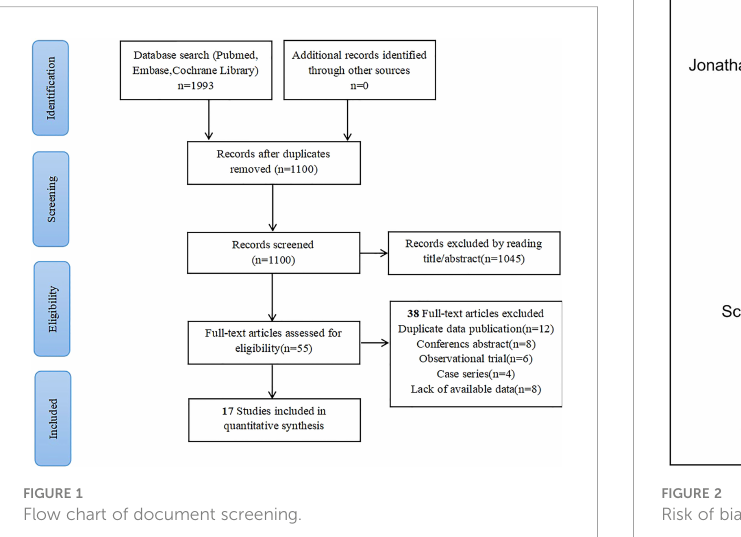
FIGURE 1 Flow chart of document screening.